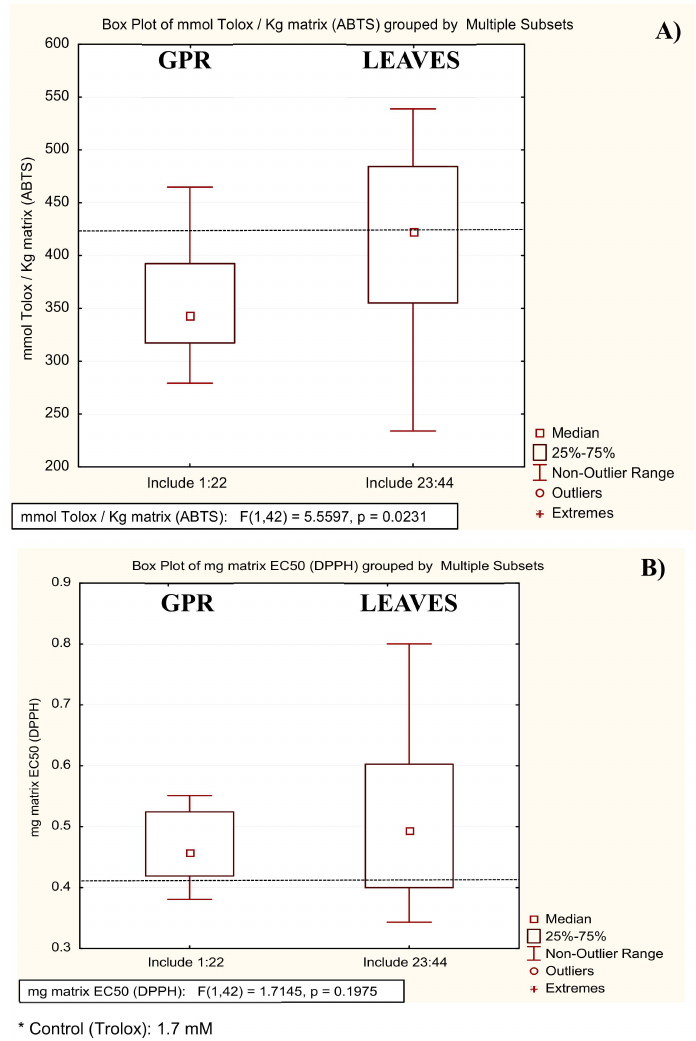
Figure 4. Box plots relative to the in vitro colorimetric antioxidant assays: Trolox equivalent antioxidant capacity (TEAC) by ABTS Assay expressed as mmol Trolox / kg matrix ( A ) and EC50 (mg matrix) by DPPH assay ( B ). The dashed line gives the literature values (i.e., [30] for A , and [31] for B